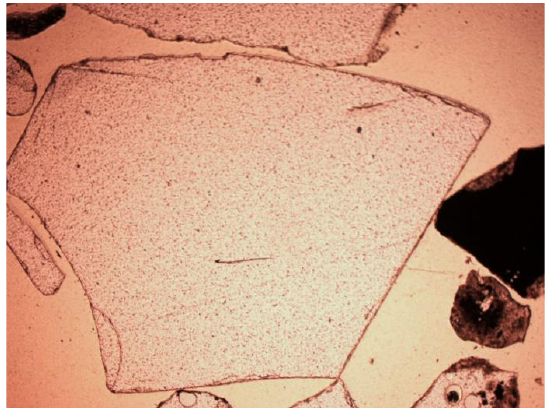
Figure 14. Glass in SP2 slag and ash sample, thin section, 1P, 200×, transmitted light.